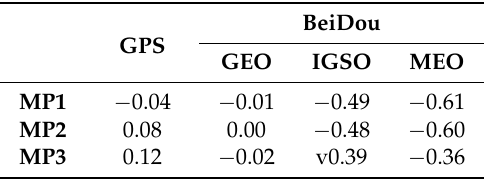
Table 1. Correlations between MP and elevation